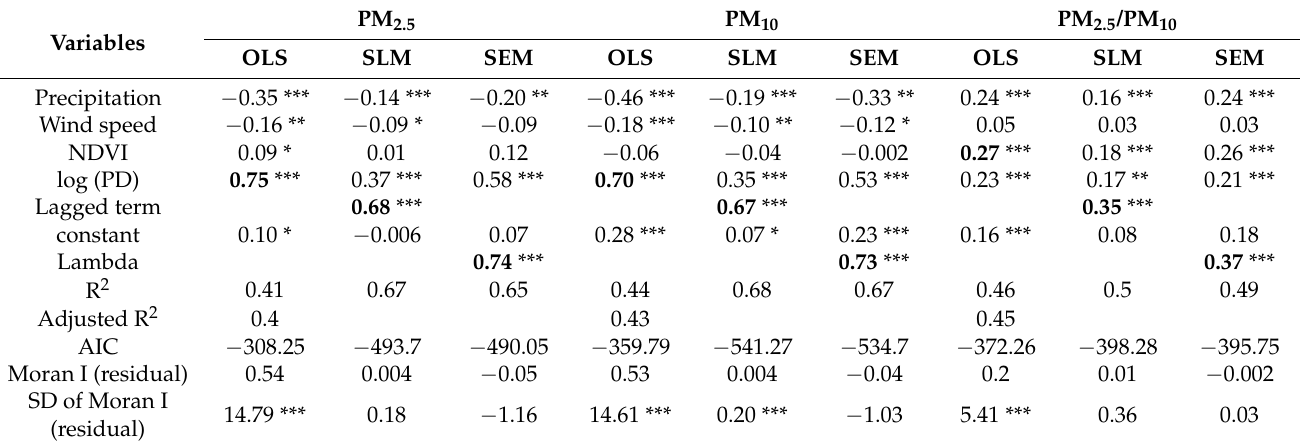
Table 3. Regression results of PM 2.5 , PM 10 , and PM 2.5 /PM 10